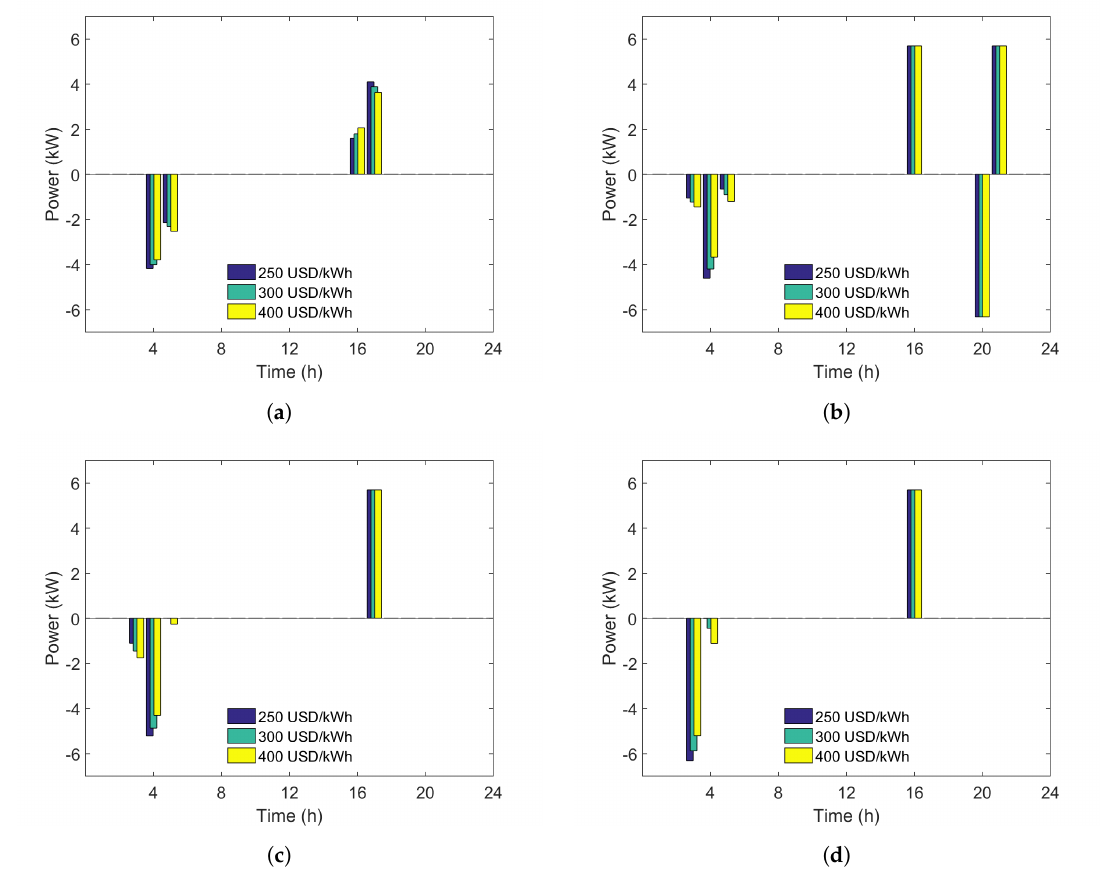
Figure 4. Optimal operation for a “complex tariff” example during a 24 h period, for the days that present a large price variation. p C : optimal power consumed from the grid (represented as negative for t visual purposes) and p D : optimal power supplied by the battery (positive). ( a ) Extremely Hot t